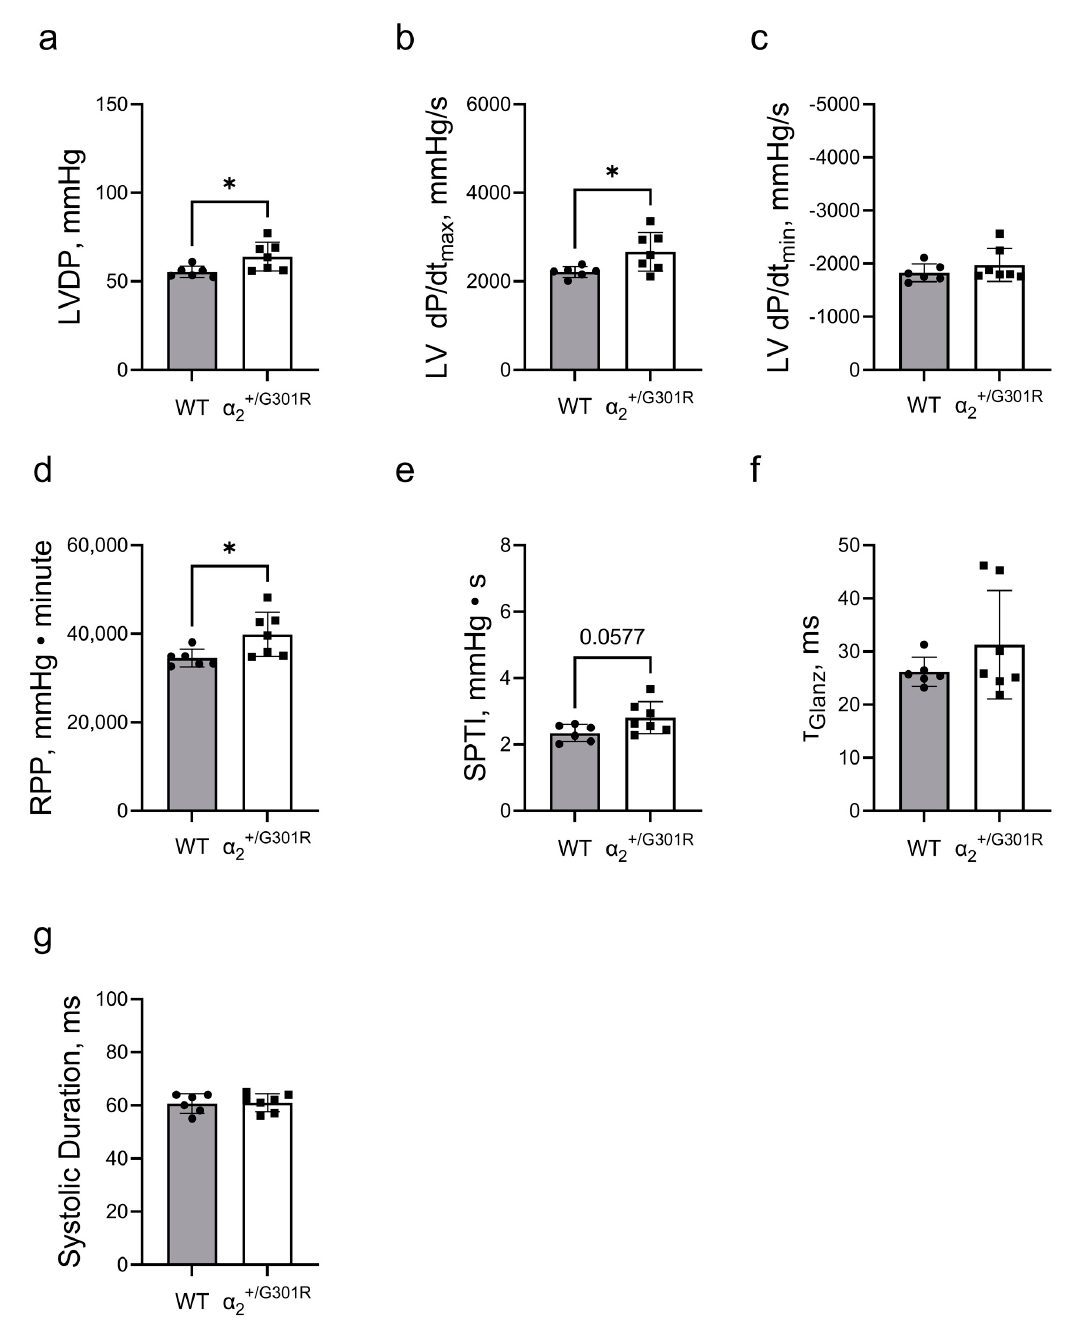
Figure 6. In the presence of ouabain cardiac contractility was more enhanced in α 2+/G301R hearts than in WT hearts during atrial pacing at 10.5 Hz (630 BPM). ( a ) Left-ventricular-developed pressure (LVDP) and ( b ) the left ventricular dP/dt max (LV dP/dt max ) of α 2+/G301R hearts were greater than those of WT hearts during atrial pacing in the presence of ouabain. ( c ) There was no difference between the groups in left ventricular dP/dt min (LV dP/dt min ). ( d ) The rate–pressure product (RPP) was larger for α 2+/G301R hearts than for WT hearts, but ( e ) the difference in the systolic pressure–time index (SPTI) between the two genotypes did not achieve statistical significance ( p = 0.0577) during atrial pacing and in the presence of ouabain. There were no differences in ( f ) τ Glanz and ( g ) systolic duration between the two groups. Data were compared with an unpaired t -test or a Mann–Whitney test. * p < 0.05; WT vs. α 2 +/G301R variables. n =